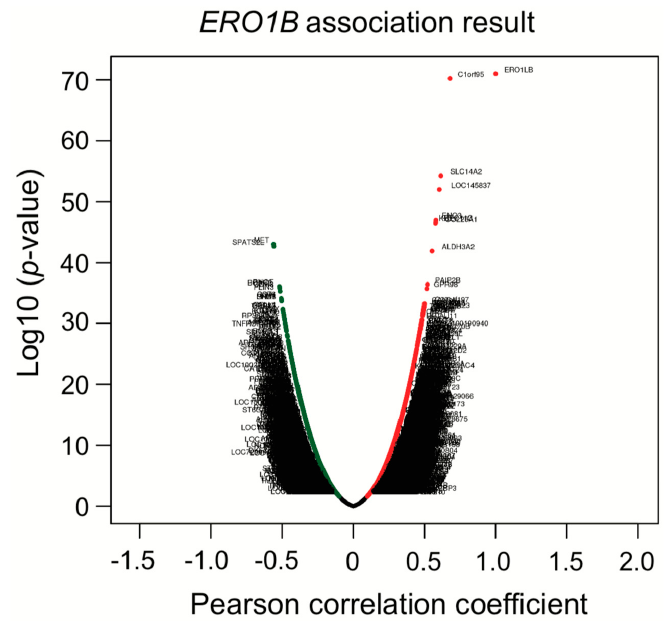
Figure5. Co-expressionanalysisof ERO1B .CorrelationanalysiswasperformedwithPearsoncorrelation Figure 5. Co-expression analysis of ERO1B . Correlation analysis was performed with Pearson test against ERO1B correlation test against ERO1B gene.